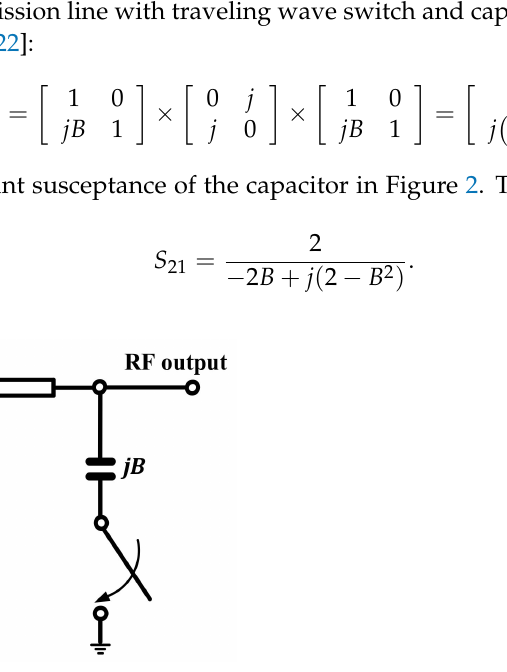
Figure 5. Schematic of transmission line with traveling wave switch and capacitive loaded phase